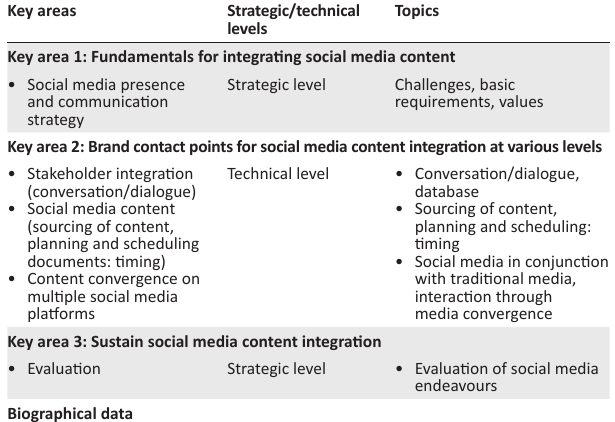
TABLE 2: Key areas and topics explored during the semi-structured interviews.